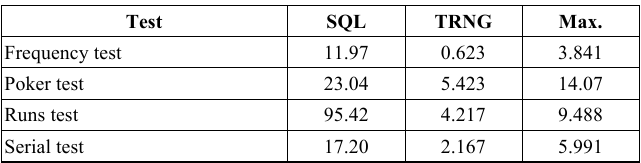
Fig. 11. C pseudo code for calculating the Threshold array Table 2. Randomness test